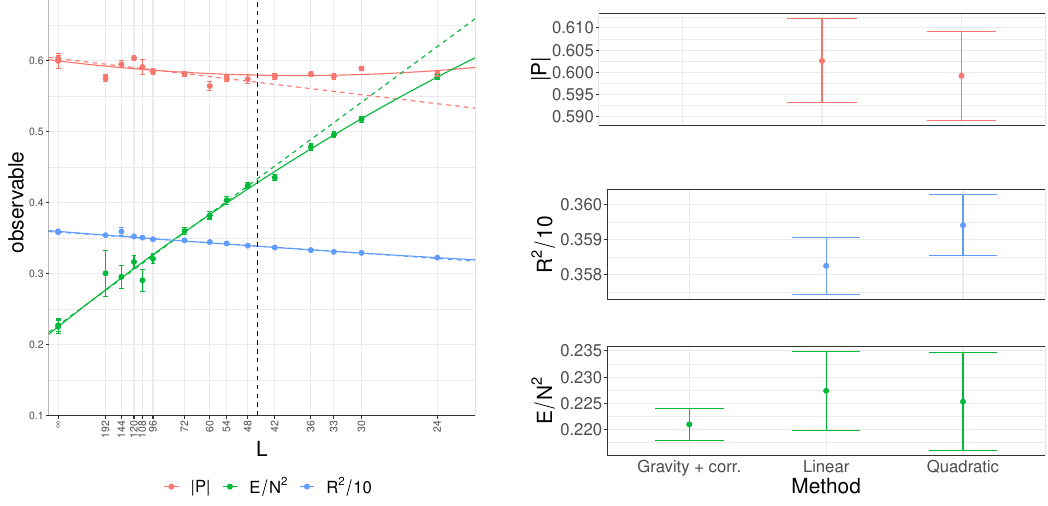
Figure 10 . [Left] The extrapolation to the continuum limit ( L → ∞ ) for T = 0 . 3 , N = 16 , µ = 0 . 5 . Solid lines are quadratic fits in 1 . Dashed lines are linear fits in 1 that used the data points at the L L left of the dashed black line. These extrapolation ansätze lead to consistent extrapolation values. [Right] The continuum-extrapolated values are shown. For the energy, we also show the classical gravity prediction at µ = 0 . 5 including α 0 and finite N corrections that were estimated using matrix model simulations. Specifically, we use a 1 , a 2 , b 1 as estimated in [13] from BFSS simulations at T ≥ 0 . 4 . Additionally, we use ε 2 , 0 as estimated in table 2, which gives a significant contribution of +0 . 007 . Error bars on the gravity result originate from uncertainties on the coefficients a 1 , a 2 , b 1 , ε 2 , 0 and don’t include an estimation of higher order corrections.